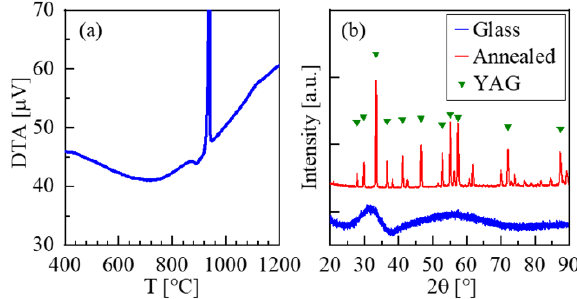
Figure 1. ( a ) Differential thermal analysis (DTA) curve and ( b ) X-ray diffraction (XRD) patterns of the prepared 62.5Al 2 O 3 -37.5Y 2 O 3 glass sample. The XRD pattern for the ample after annealing at 920 °C for 30 min is also shown in ( b ).